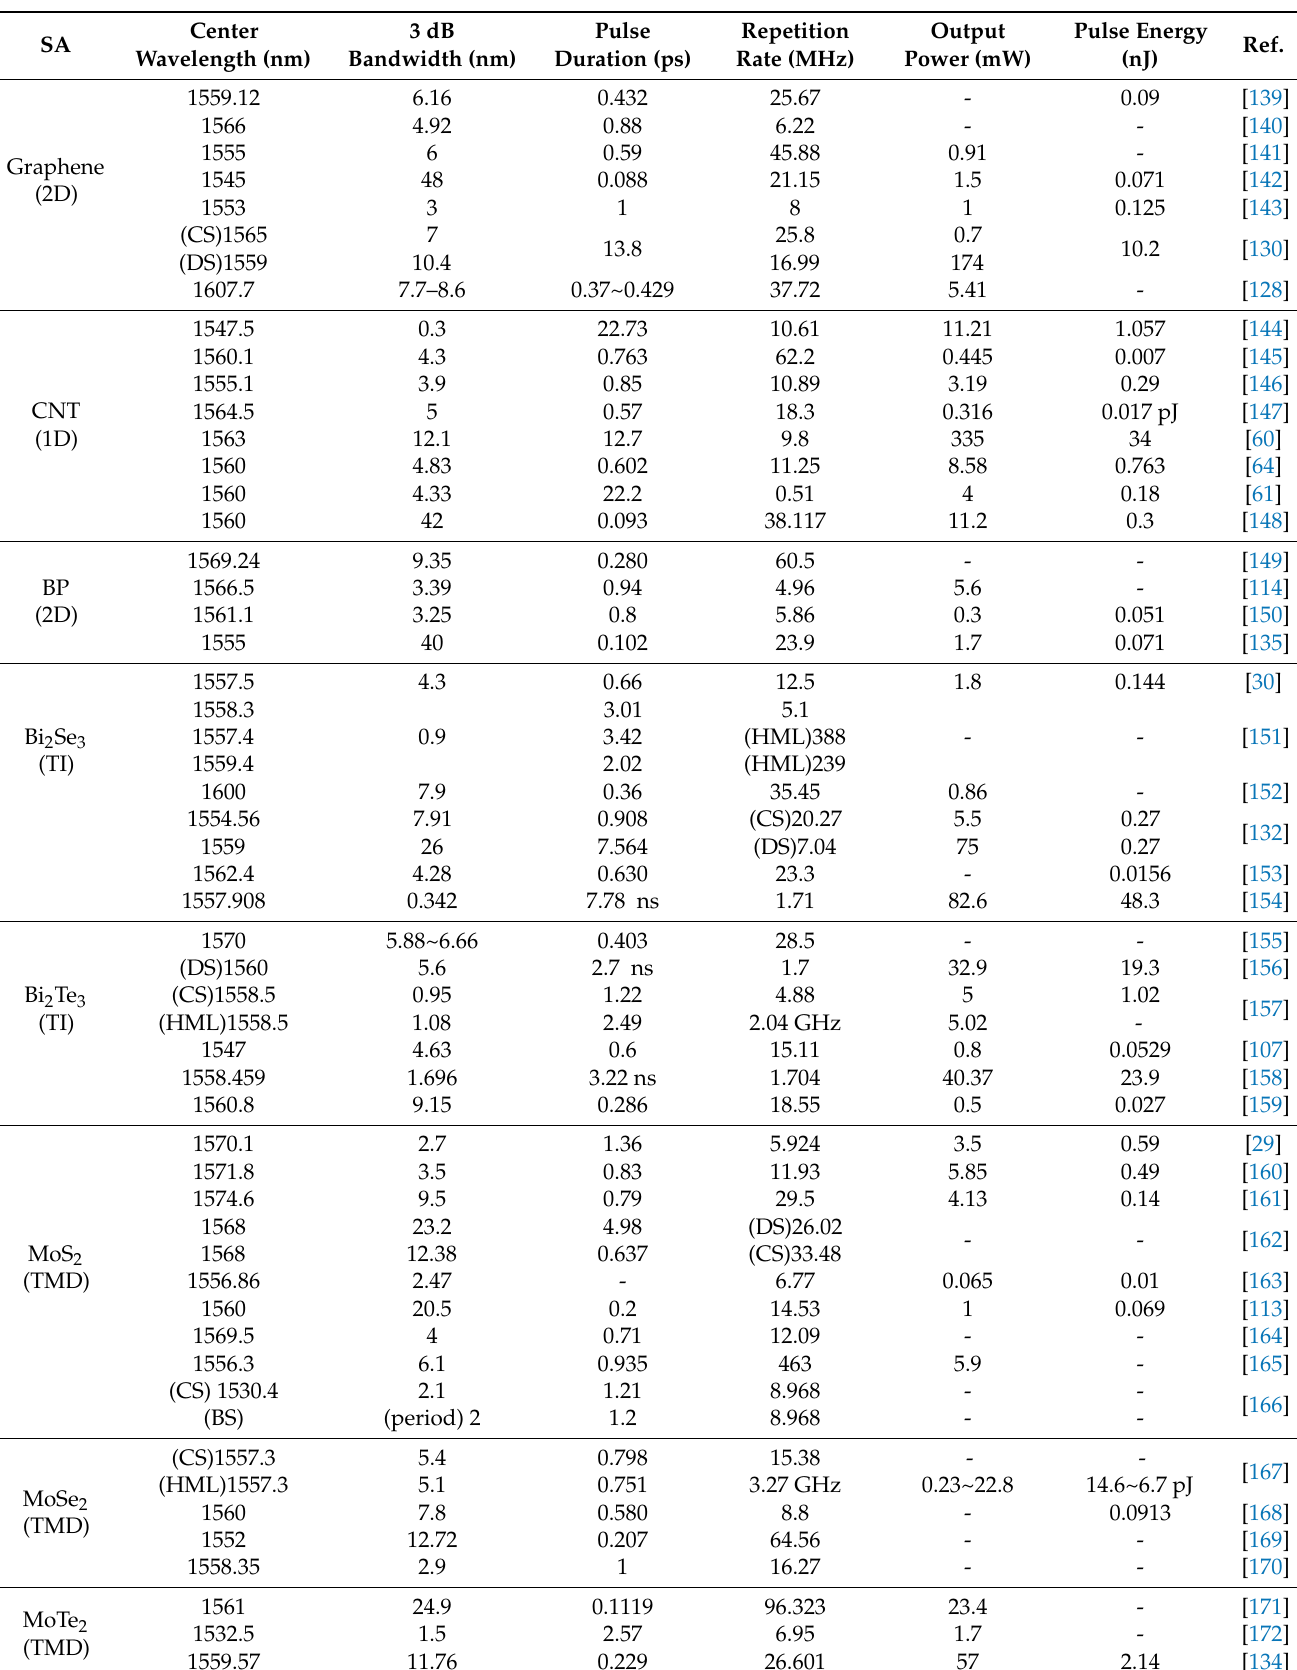
Table 1. Summary of the characteristics of various LD SA-based ultrafast fiber lasers operating at ~1.55 µ